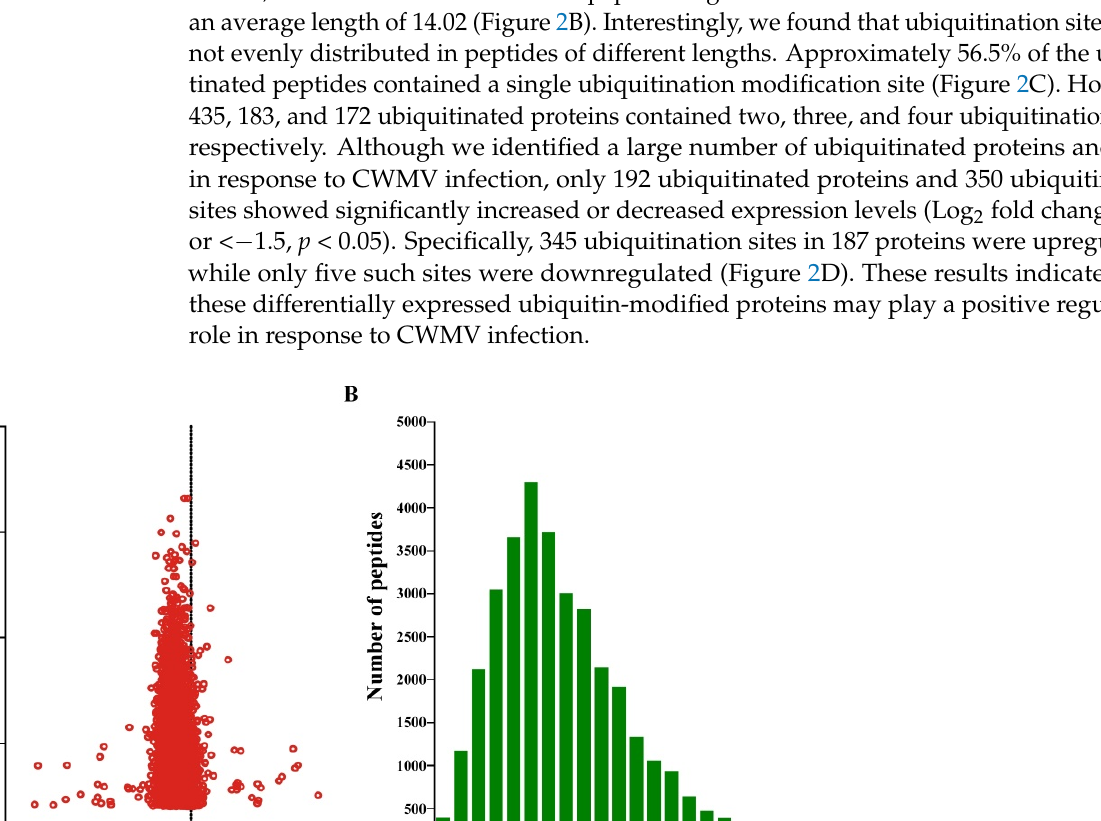
Figure 2. Characteristics of lysine-ubiquitinated sites and proteins in wheat. ( A ) Mass error distri- bution of all the identified peptides. ( B ) Peptide number and length distribution of all the ubiqui- tinated peptides. ( C ) Distribution of ubiquitination sites in the ubiquitinated proteins. ( D ) Differen- tial expression of ubiquitinated proteins and site identification in CWMV-infected wheat.